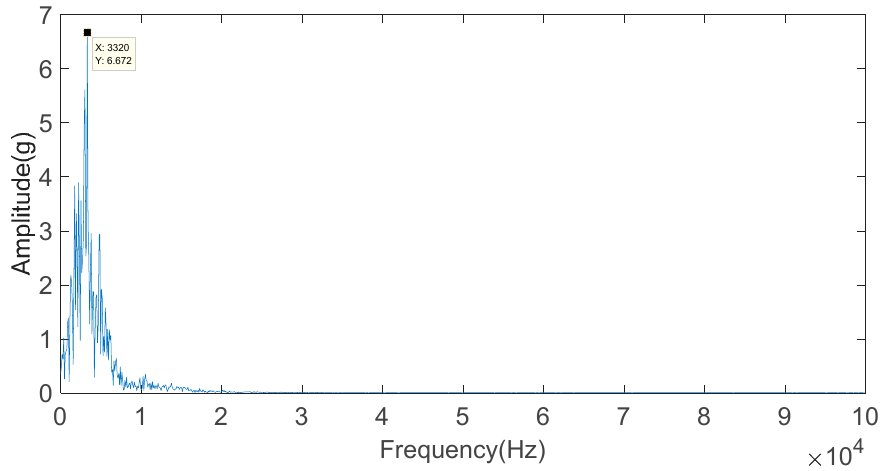
Figure 14. Frequency-domain diagram of the IMF2 component of the engine block vibration signal under a weak knock condition at 5100 rpm.